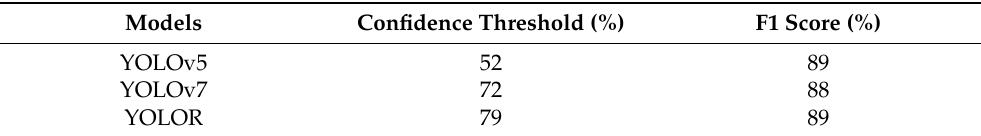
Table 8. Confidence threshold that optimizes the F1-score for each YOLO model with Grapevine Bunch Condition Detection